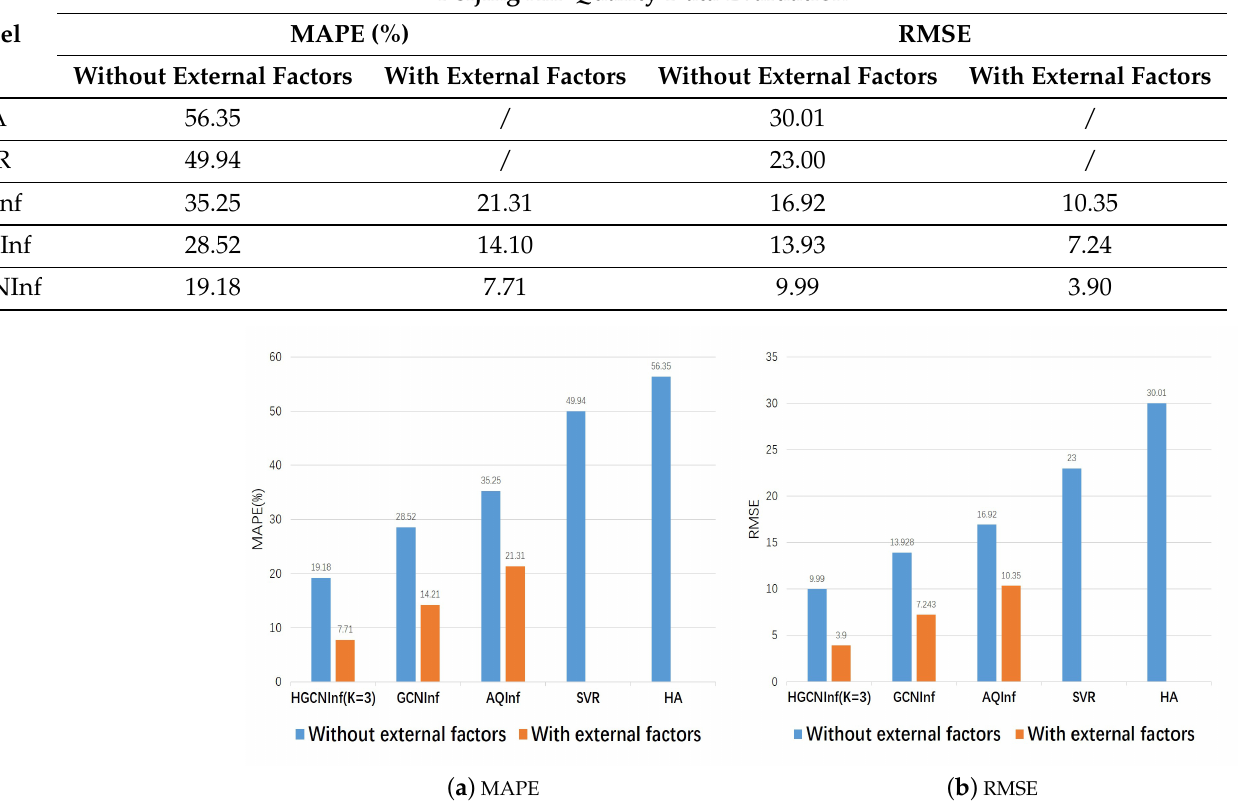
Figure 8. The performance comparison of each inference